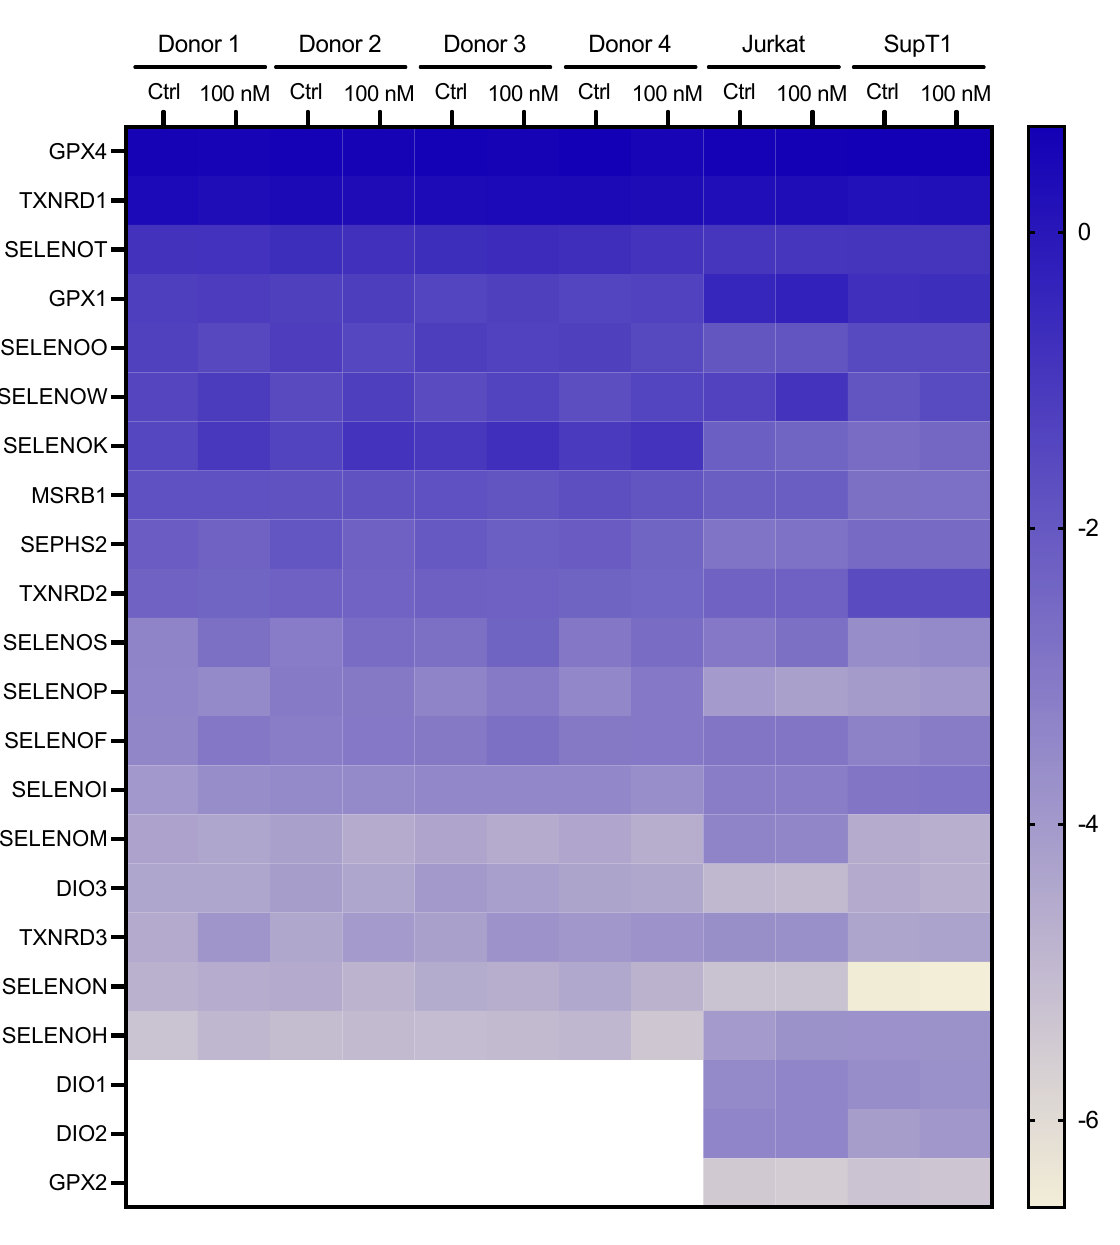
Figure 3. Heatmap representation of selenoprotein mRNA levels (in logarithmic scales) as a function of T-cell types (donors 1 to 4, Jurkat and SupT1) and growth conditions (Ctrl or supplemented with 100 nM of selenium). The values are given in Tables S1 and S2.